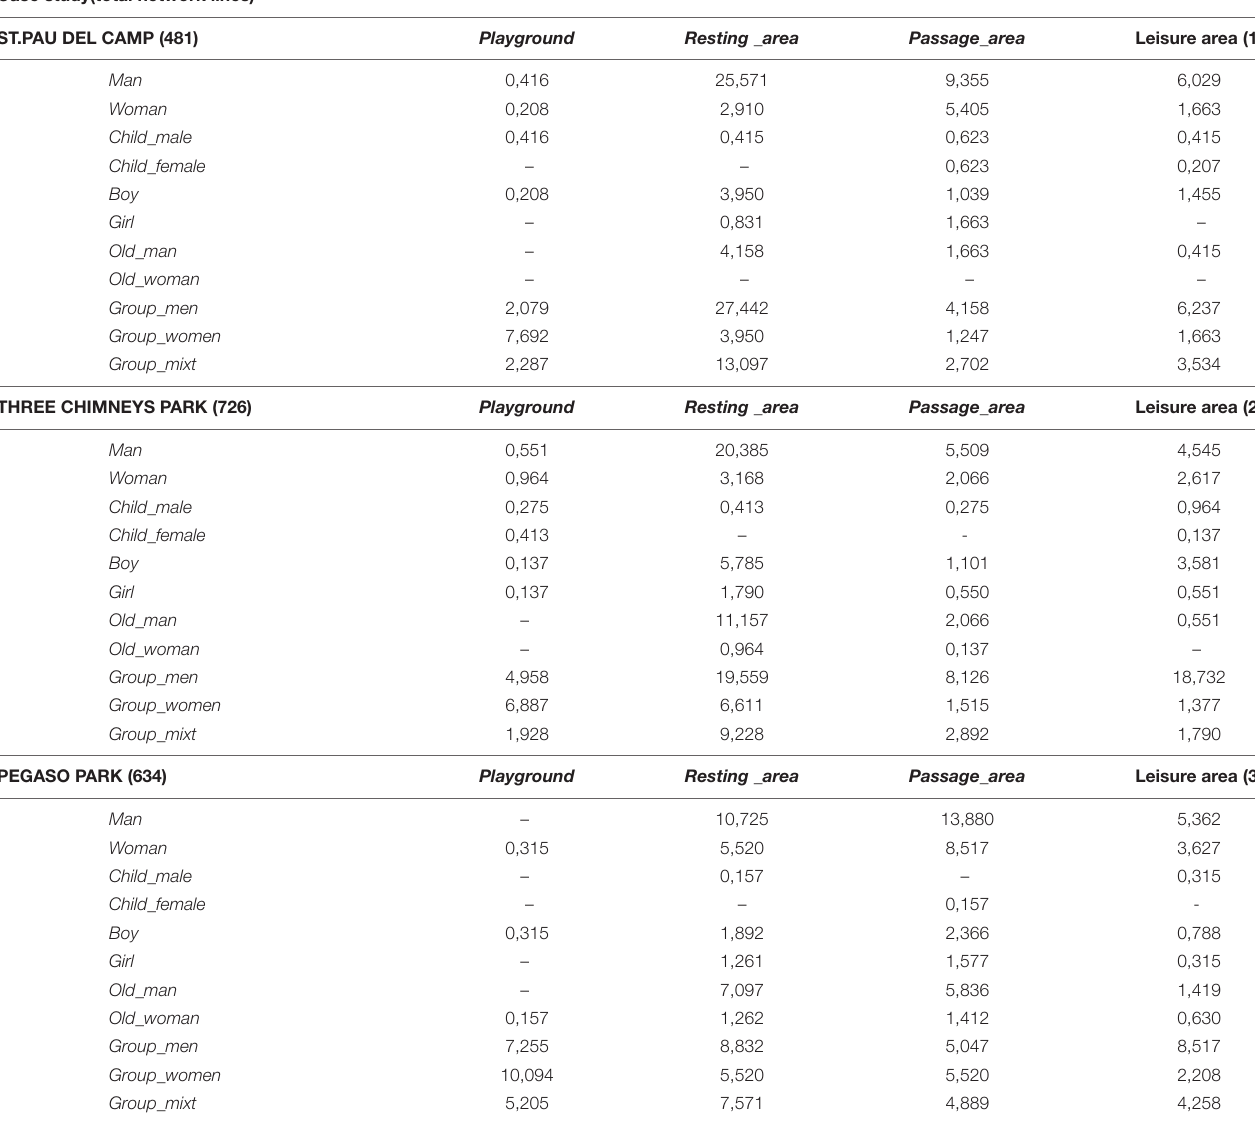
TABLE 4 | Gender index by functional